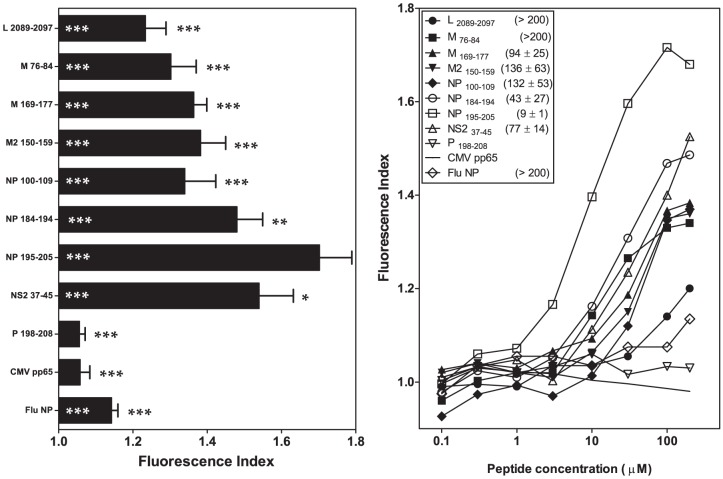
HLA-B*2702 stabilization with synthetic HRSV ligands.The stability of HLA-B*2702/peptide complexes on the cell surface of transfected RMA-S cells was measured through flow cytometry. The results shown in left and right panels are depicted as in Fig. 1A and 2B, respectively, showing the mean values obtained from three or four independent experiments.